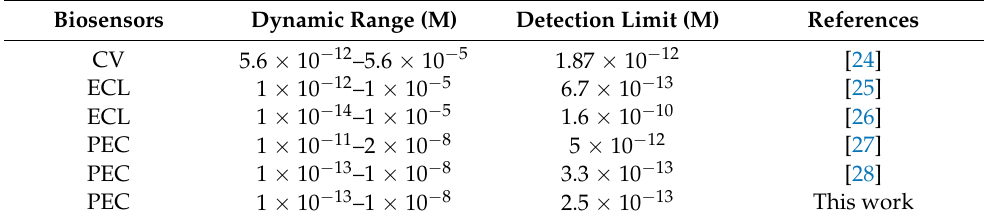
Figure 7. ( a ) Photocurrent response in detection buffer of the biosensor with different microRNA-155 concentrations ( b ) calibration curve, ( c ) stability of the PEC biosensor with 1 nM microRNA-155, and ( d ) selectivity of the PEC microRNA-155 biosensor with 1 nM different microRNAs. Table 1. Analytical performance of several microRNA-155 biosensors.